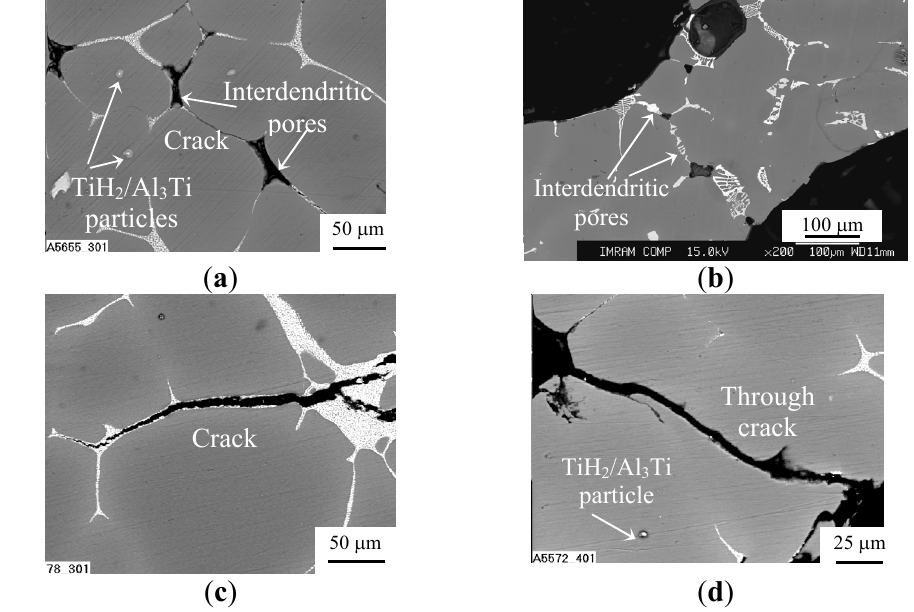
Figure 1. SEM images for microstructure of cell wall material for ( a , c , d ) ZAM 1 and ( b ) ZAM 2 foams processed with no Ca additive and produced using ( a , c , d ) TiH : ( a , b ) before and ( c , d ) after final heat ( b ) CaCO 3